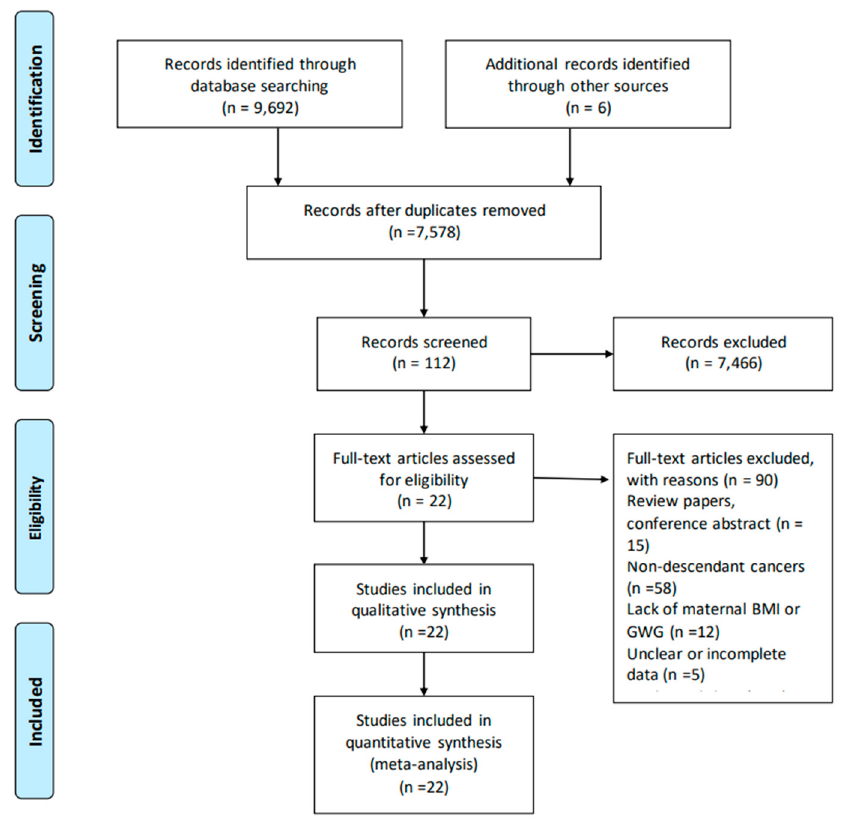
Figure 1. Flow diagram of search strategy and study exclusion with specific reasons.